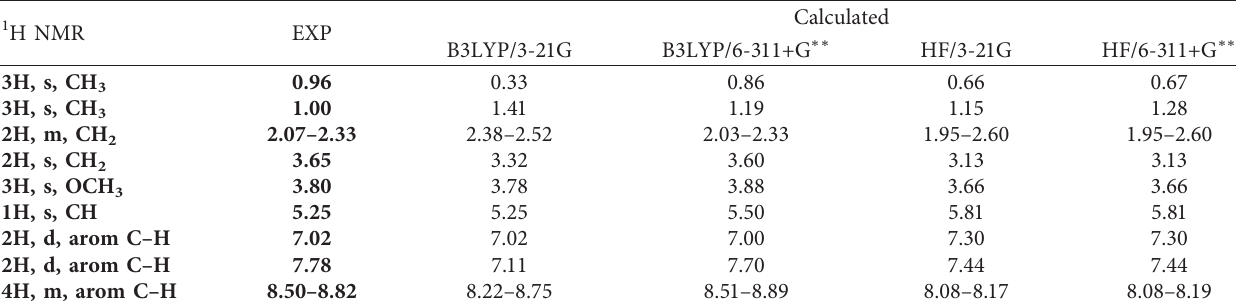
Table 5: Experimentally measured and calculated 1 H chemical shifts δ (ppm vs TMS) of the compound (5a) . 1 H